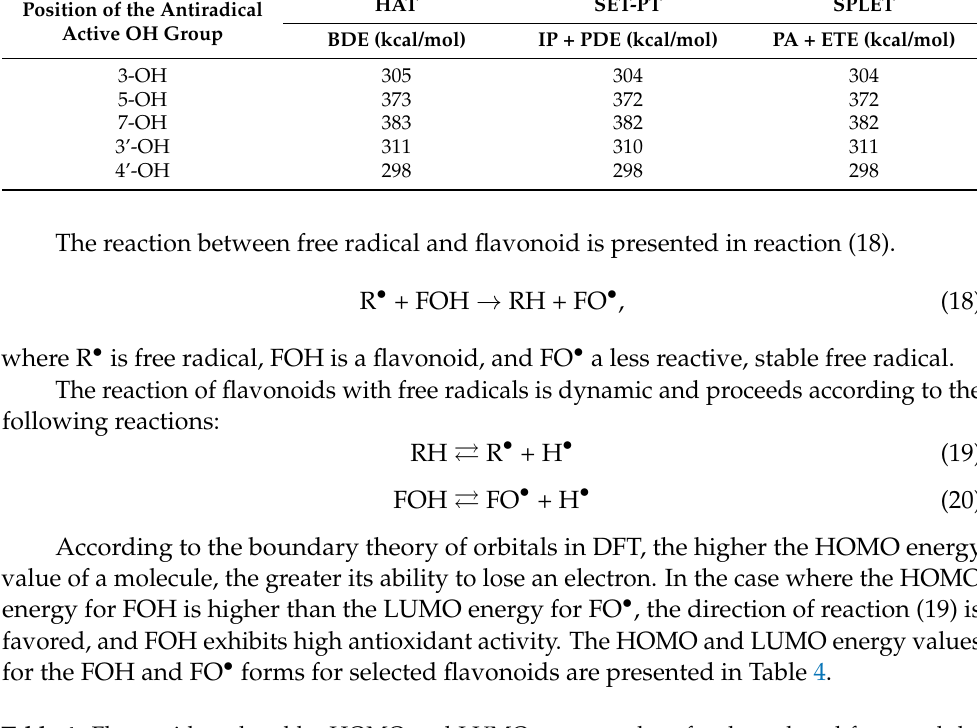
Table 4. Flavonoids ordered by HOMO and LUMO energy values for the reduced form and the corresponding radical form. Based on